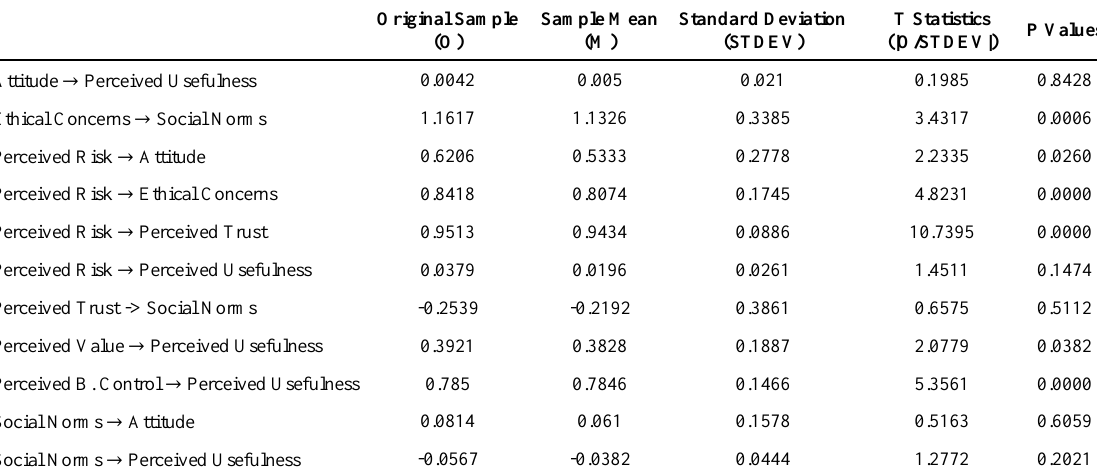
Table 10. Bootstrapping: Mean, STDEV, T-Values, P-Values